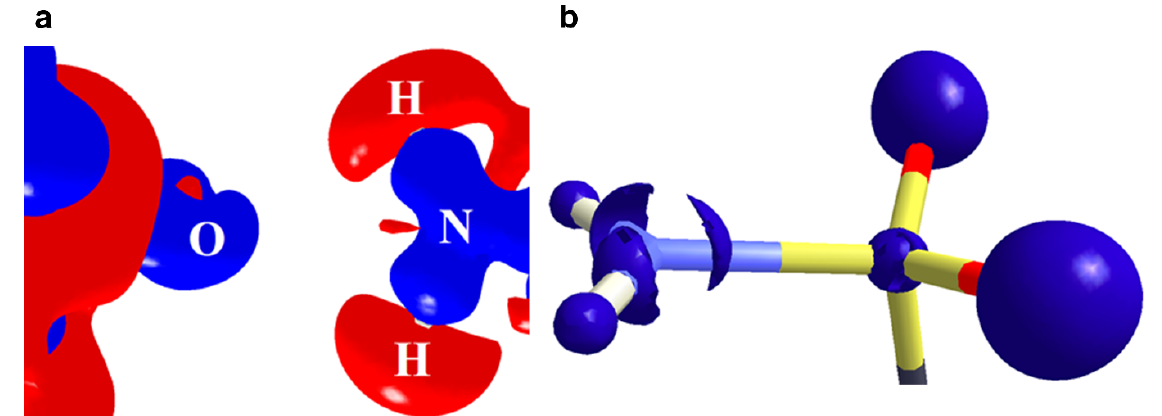
Figure 13. ( a ) Experimental 3D deformation density of the N∙∙∙O pnicogen bond interaction region drawn at the intervals of ±0.08 e∙Å −3 . Blue represents charge concentration (CC) and red represents charge depletion (CD). ( b ) Experimental 3D Laplacian isosurfaces around the N atom of sulphonamide group plotted at − 40 eÅ − 5 contour level. Figure reproduced from reference [63]. Lyssenko et al. investigated pnicogen bonding in ammonium chloride ( P -43 m) crystal using 120 K high-resolution (sin θ / λ = 1.2 Å − 1 ) X-ray diffraction data [79]. They